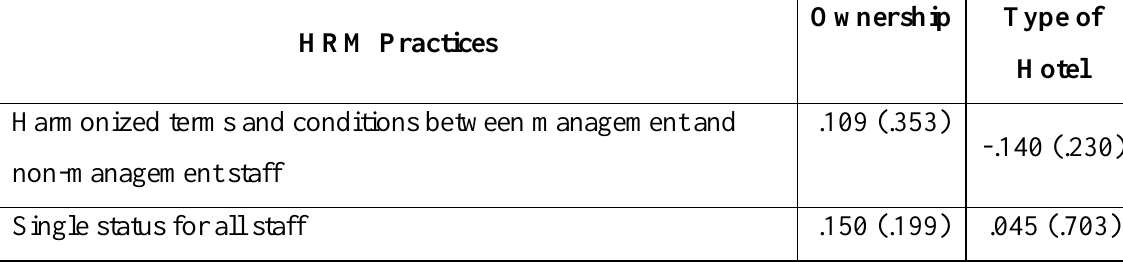
Table 5: Spearman Correlation